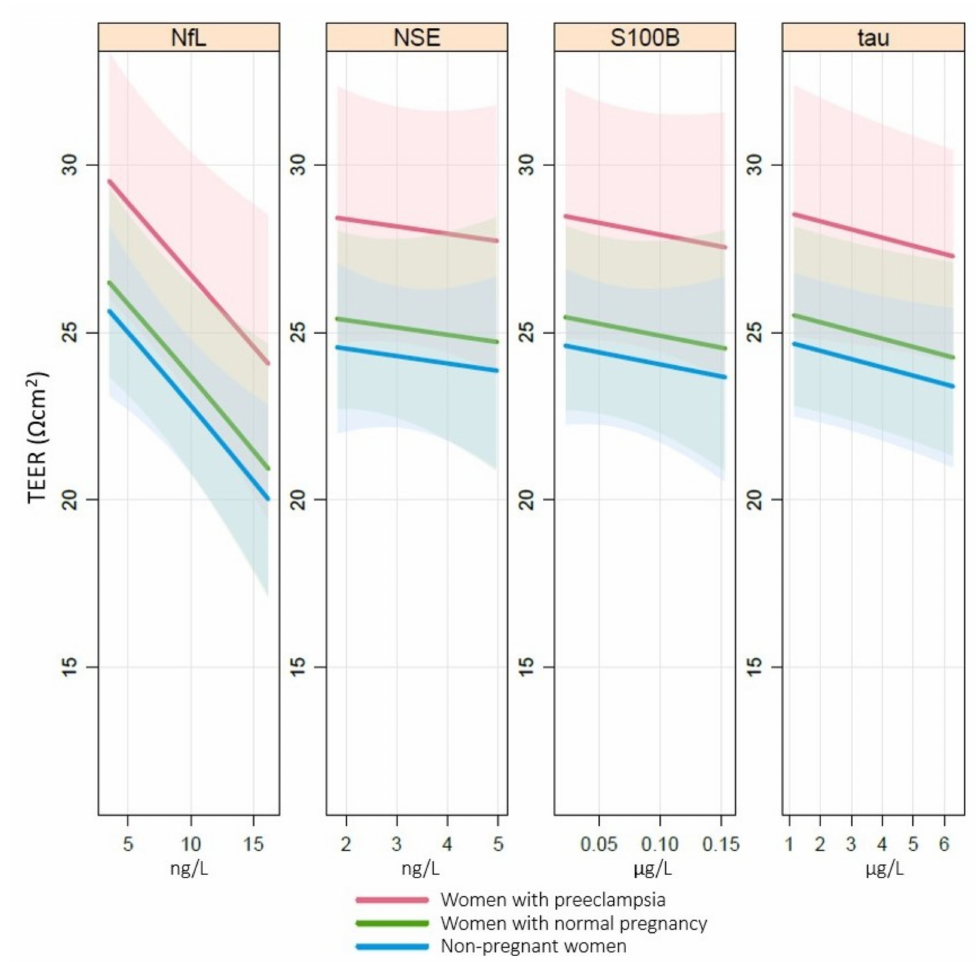
Figure 3. Association of TEER with NfL, tau, NSE and S100B. Associations between transendothelial electrical resistance (TEER ( Ω cm 2 )) and cerebral biomarkers neurofilament light (NfL (ng/L)), tau (ng/L), neuron-specific enolase (NSE ( µ g/L)) and S100B ( µ g/L) in plasma analyzed by a cumulative probability model stratified by group and adjusted for baseline TEER, body mass index, parity and maternal age. NfL p < 0.01, tau p = n.s., NSE p = n.s., S100B p =